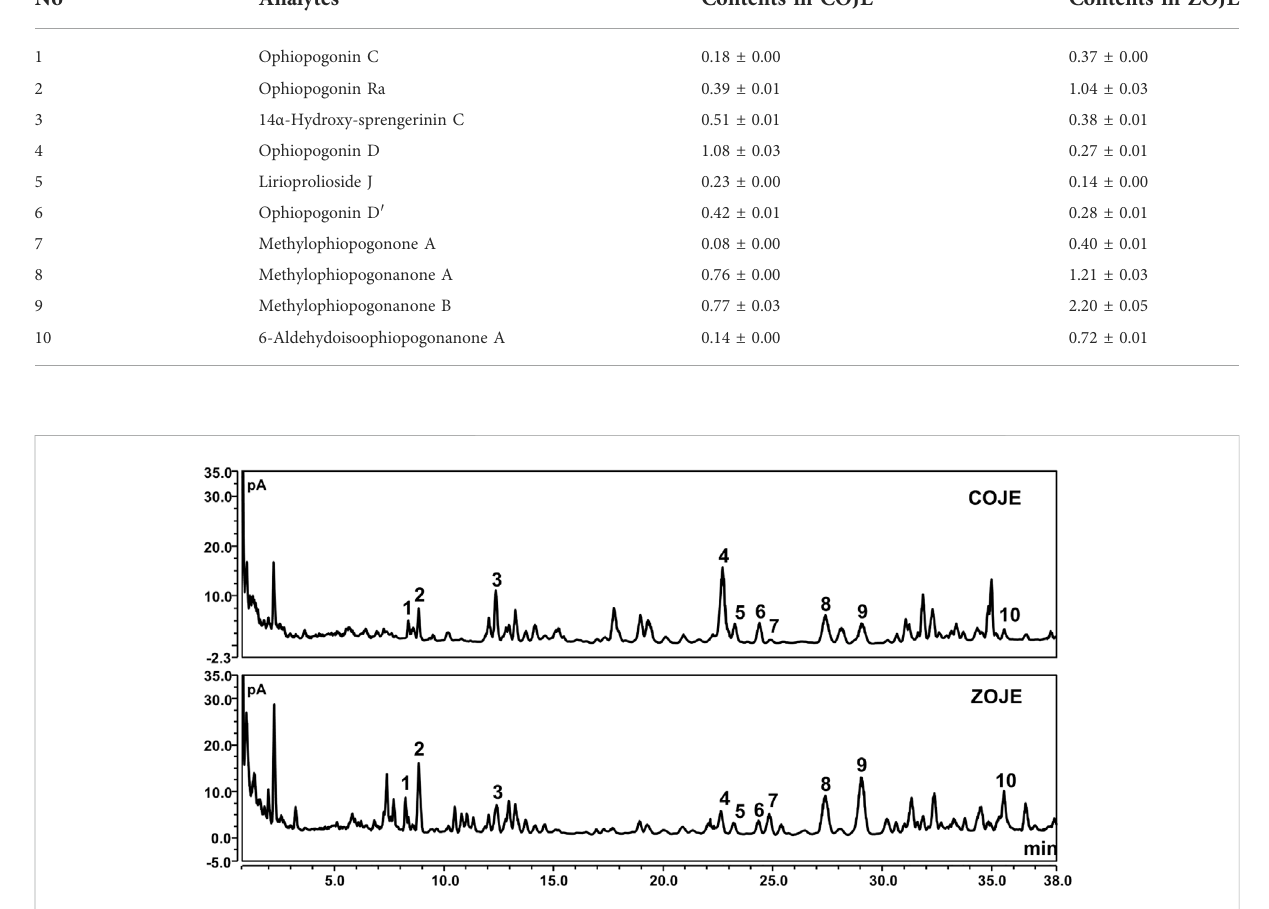
FIGURE 1 UHPLC-CAD chromatograms of COJE and ZOJE samples. 1 . ophiopogonin C, 2 . ophiopogonin Ra, 3 . 14 α -hydroxy-sprengerinin C, 4 . ophiopogonin D, 5 . lirioprolioside J, 6 . ophiopogonin D ′ , 7 . methylophiopogonone A, 8 . methylophiopogonanoneA, 9 . methylophiopogonanone B, 10 .6-aldehydoisoophi opogonanone